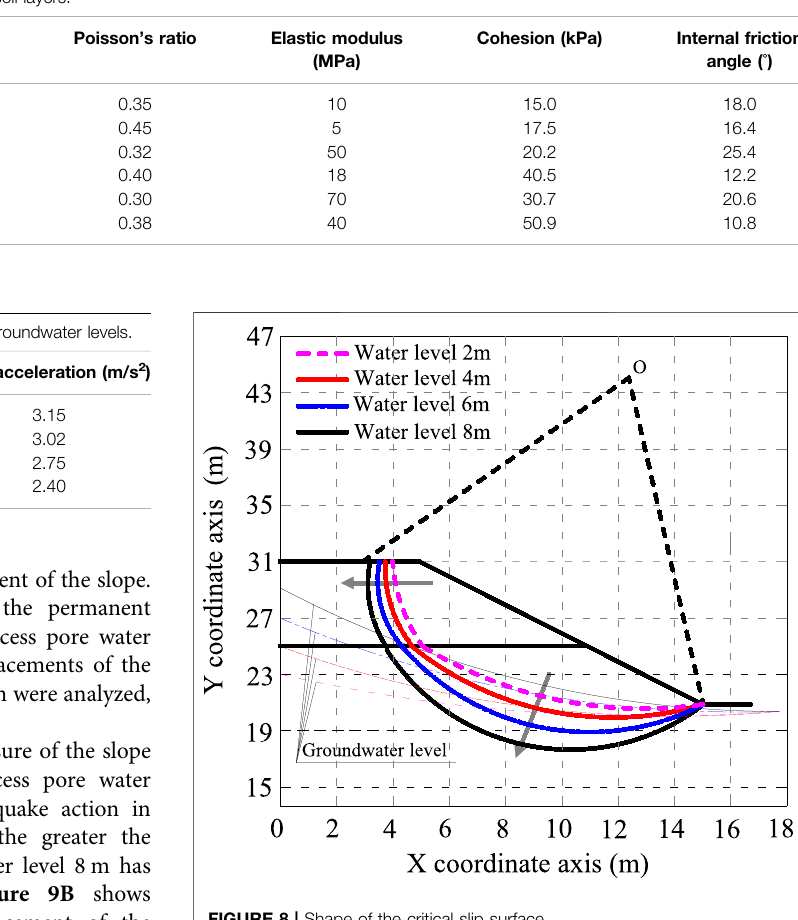
FIGURE 8 | Shape of the critical slip